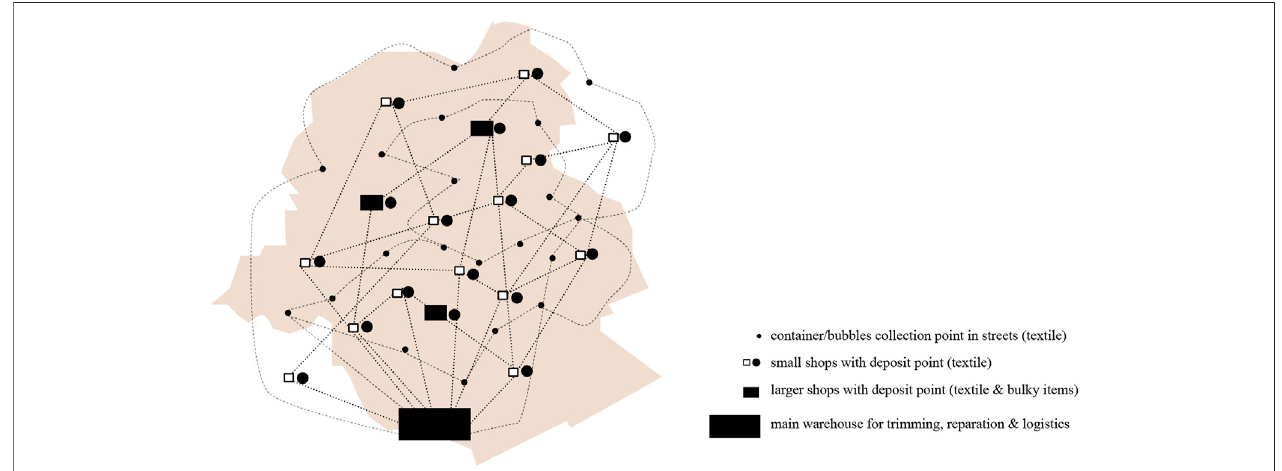
FIGURE 8 | Diagram showing the spatial constellation of Les Petits Riens-Spullenhulp , by the authors.